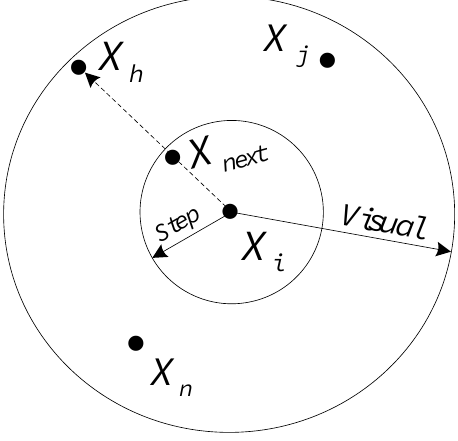
Figure 2. Concept of artificial fish